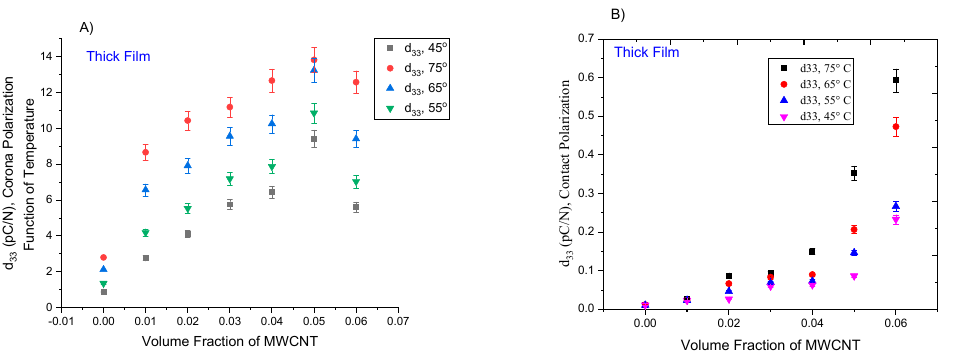
Figure 10. Piezoelectric strain coefficient of thick films as a function of polarization temperature and volume fraction of MWCNTs for ( A ) corona and ( B ) contact polarization conditions.